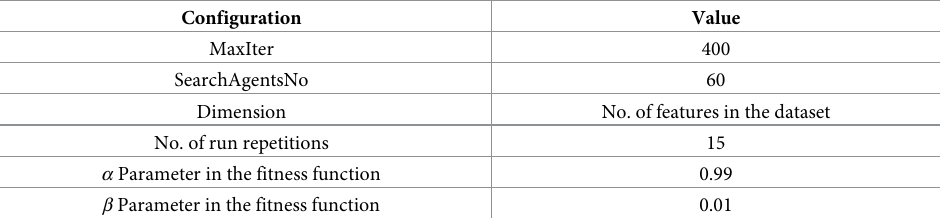
Table 1. Configuration values for the WOA